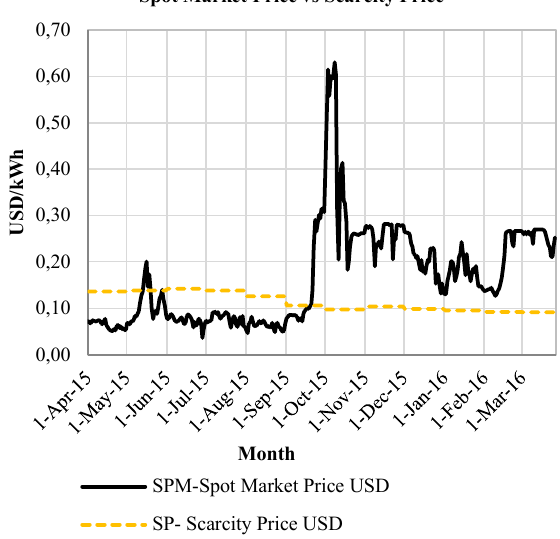
Fig. 1. Comparison between the Scarcity Price and the Spot Market Price in Colombia, 2015. Note: The prices were converted into USD using the same ECR of SP tf (adapted from